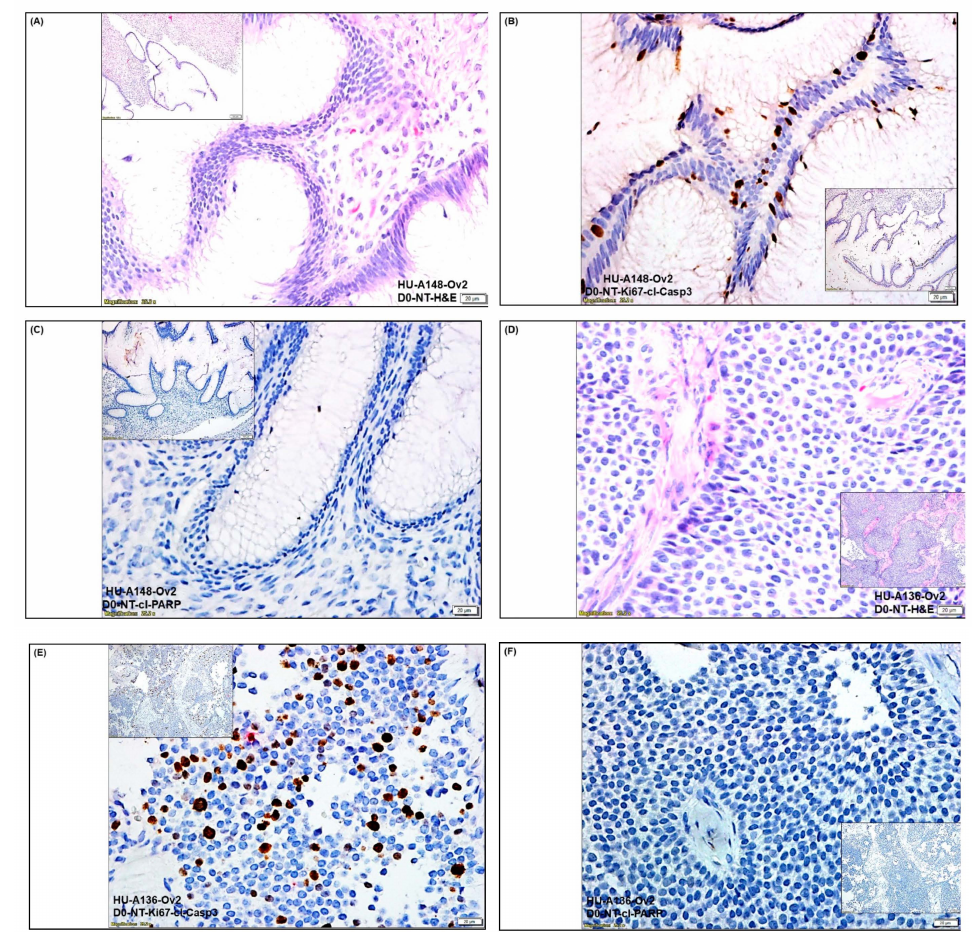
Figure 1. Expression of tumor cell proliferation and apoptotic markers in the representative tu- mor samples of ovarian cancers: We tested the expression of Ki67, cl-Casp3, and cl-PARP in two representative tumor samples from patients with ovarian cancers HU-A148-Ov2 and HU-A136-Ov2 with grade 1, stage IVA low-grade appendiceal mucinous neoplasm (pT4b pN0 pM1b) ( B , C ), and with stage IA adult granulosa cell tumor (pT1a NX) ( E , F ) by dual IHC stain for Ki67 (visualized by brown DAB color), and cl-Casp3 (visualized by pink alkaline phosphatase color) ( B , E ) as well as cl-PARP (visualized by brown DAB color) ( C , F ). The morphological features are presented by H&E stain ( A , D